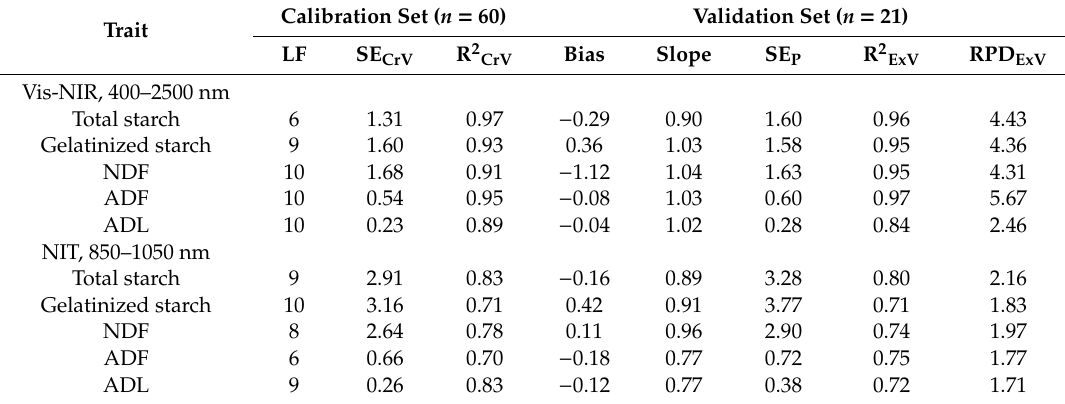
Table 5. Fitting statistics of modified partial least square regression models using external validation for total and gelatinized starch, neutral detergent fiber (NDF), acid detergent fiber (ADF), and acid detergent lignin (ADL) content (g / 100 g DM) in extruded dry dog food with visible / near-infrared reflectance spectroscopy (Vis-NIR) and near-infrared transmittance spectroscopy (NIT).